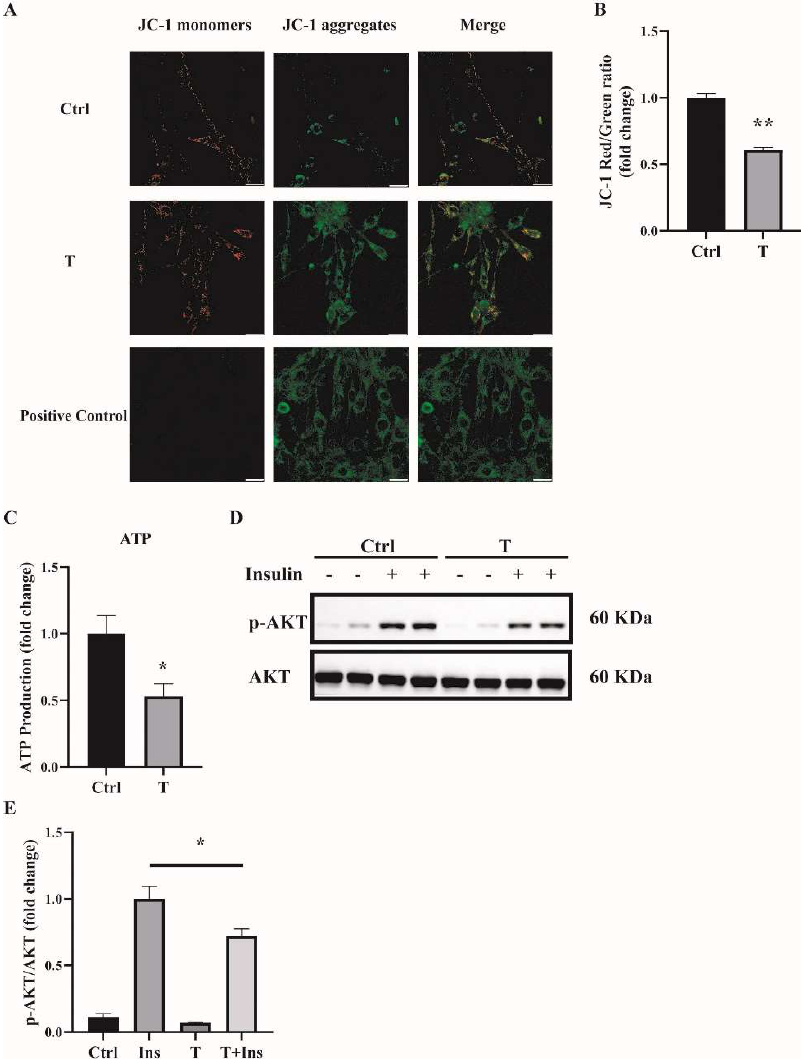
Figure 4. Impaired mitochondrial membrane potential, mitochondrial function, and insulin sensitivity in T-treated C2C12 cells. Fully differentiated C2C12 cells were treated with T (0 and 10 −5 M) for 12 h. ( A ) The mitochondrial membrane potential (ΔΨm) was determined by JC-1. Cells treated with CCCP (10 μm) for 20 min were used as the positive control. The signals were observed using fluorescence microscopy. Representative images of three independent experiments are shown. The red fluorescence represents the mitochondrial aggregate form of JC-1, indicating high ΔΨm. The green fluorescence represents the monomeric form of JC-1, indicating the dissipation of ΔΨm. Scale bar = 25 μm. ( B ) The ratios of JC-1 aggregate/monomer were analyzed by the Image J program. The reduced ratio of JC-1 red/green indicated the damaged mitochondrial membrane potential. ( C ) Normalized ATP production. ( D ) Insulin-signaling assay. ( E ) Densitometry quantification of pAKT/AKT of the insulin-signaling assay in T-treated C2C12 cells. The data are presented as means ± SEM of three independent experiments. *, p < 0.05, **, p < 0.01. T, testosterone; Ins, insulin.